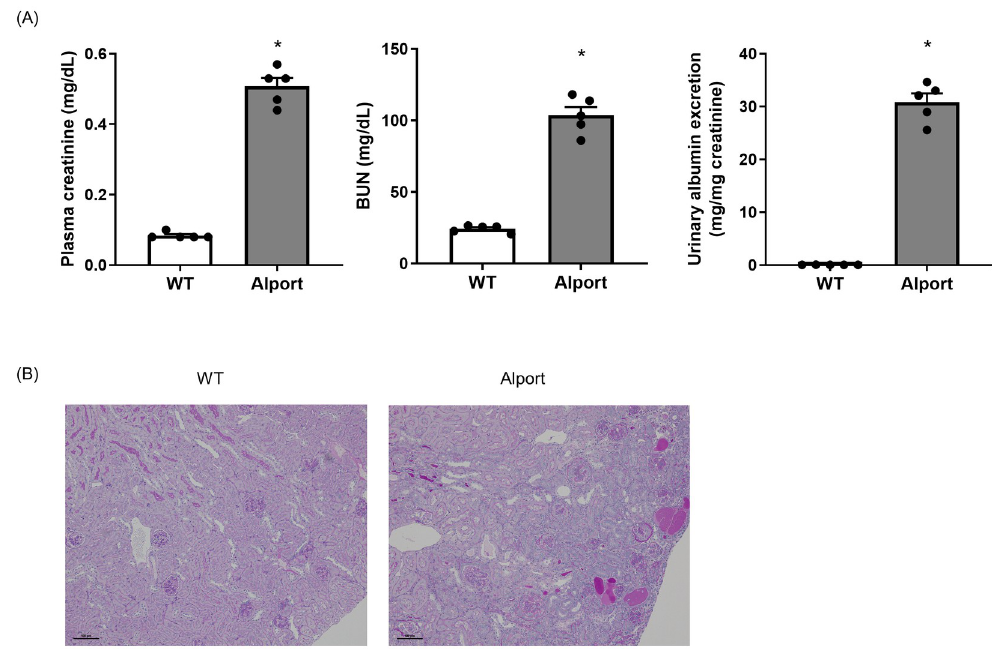
Fig 2. Kidney dysfunction in Alport mice at 20 weeks old. Plasma creatinine level, BUN, and urinary albumin excretion rate were significantly higher in Alport mice than in wild type mice at 20 weeks old (A). Representative micrographs showing PAS stained kidney sections. Scale bars indicates 100 μ m (B). The actual values are represented as dots and the columns represent mean + SE. � p < 0.05, significant difference versus WT (Student’s t-test). WT: wild type mice, Alport: Alport